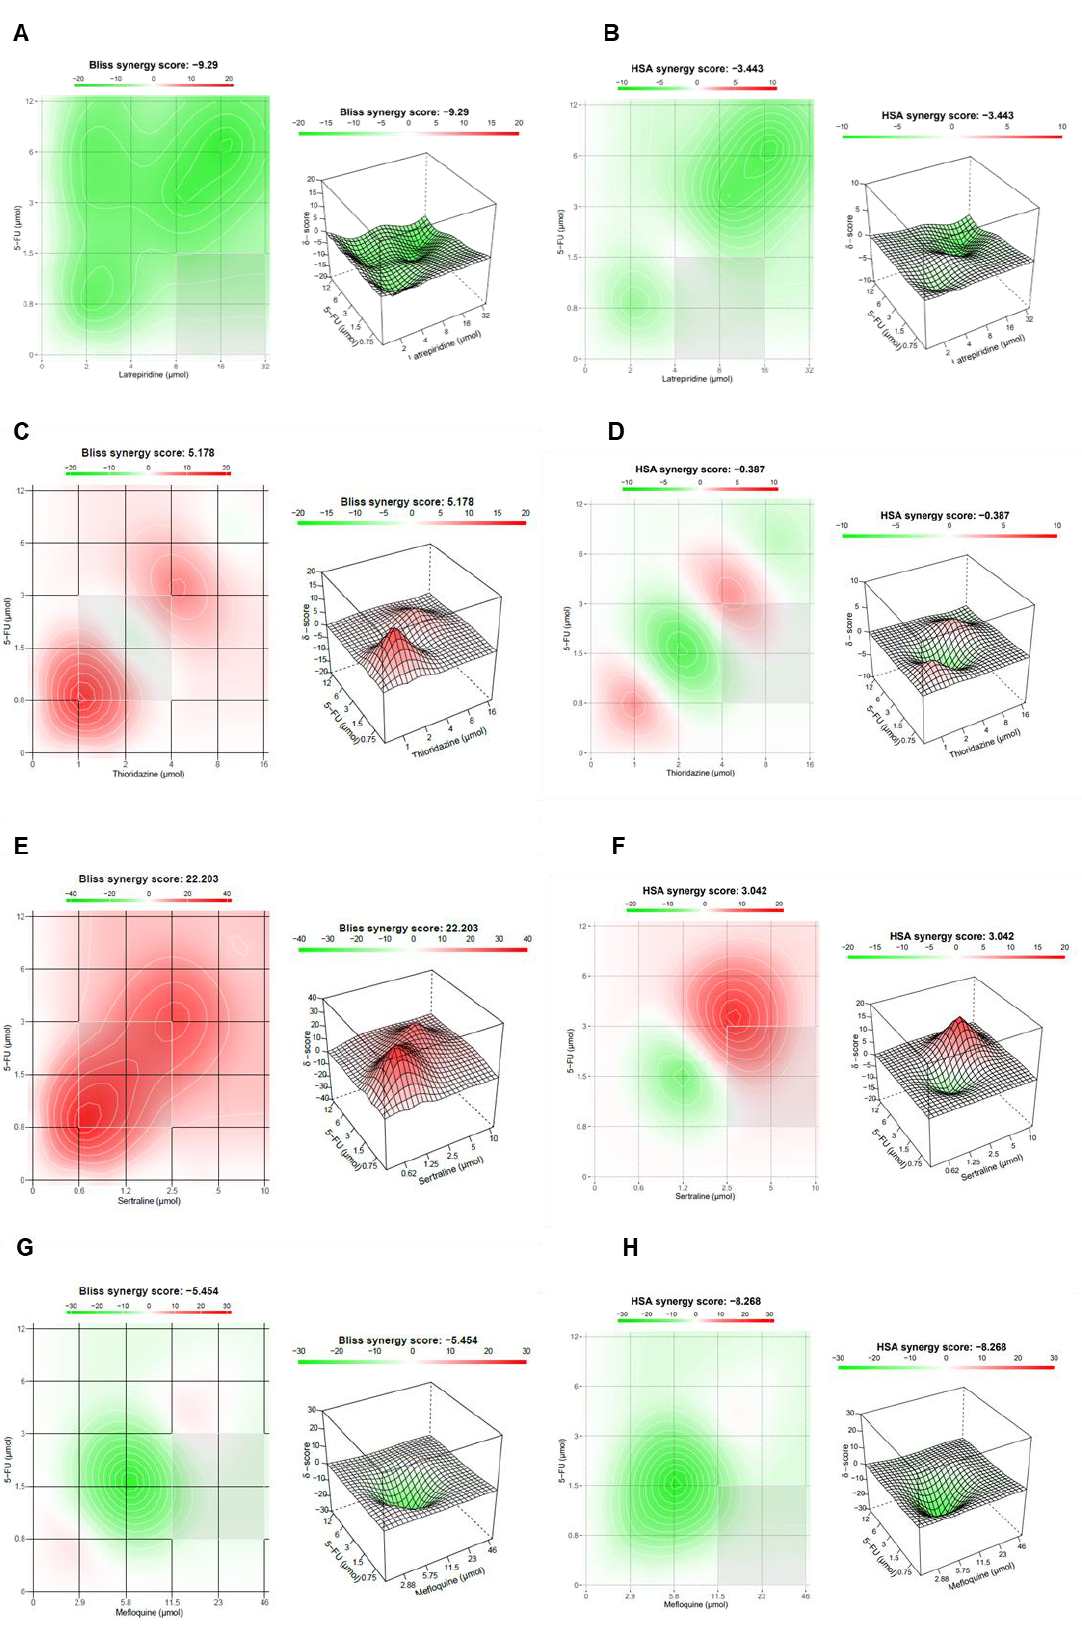
Figure 9. Bliss ( left ) and HAS ( right ) synergy plots of 5-FU plus latrepirdine ( A , B ), thioridazine ( C , D ), sertraline ( E , F ) and mefloquine ( G , H ).